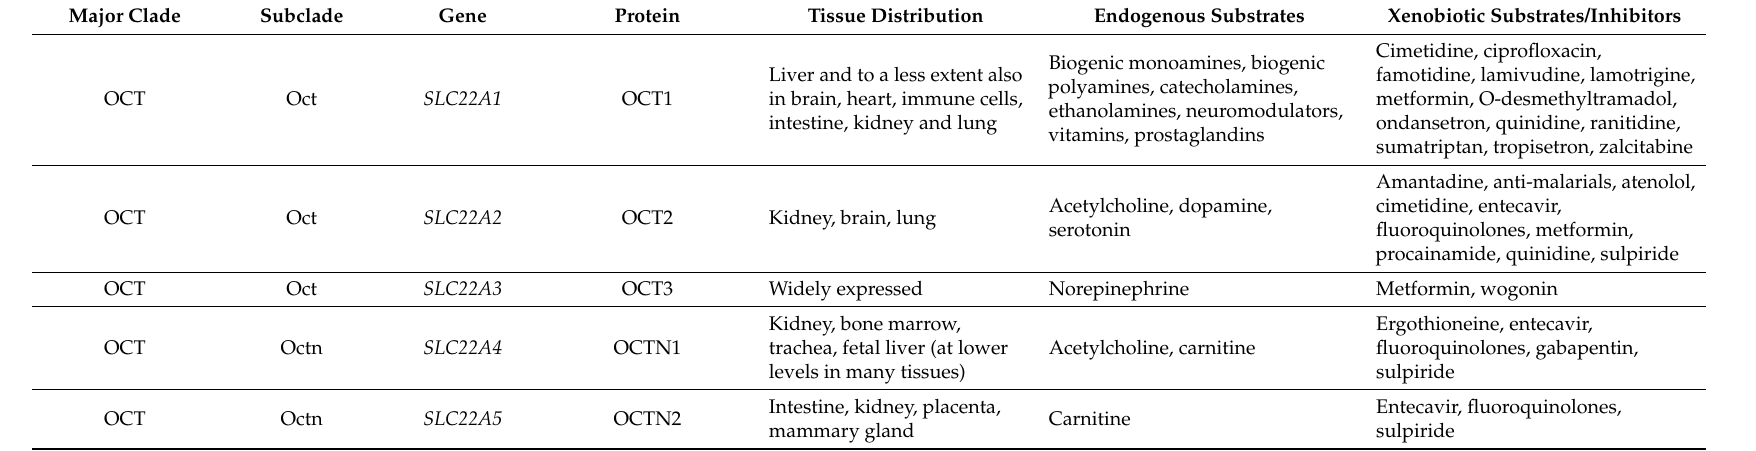
Table 1. Characteristics of the human organic cation transporters of the SLC22A